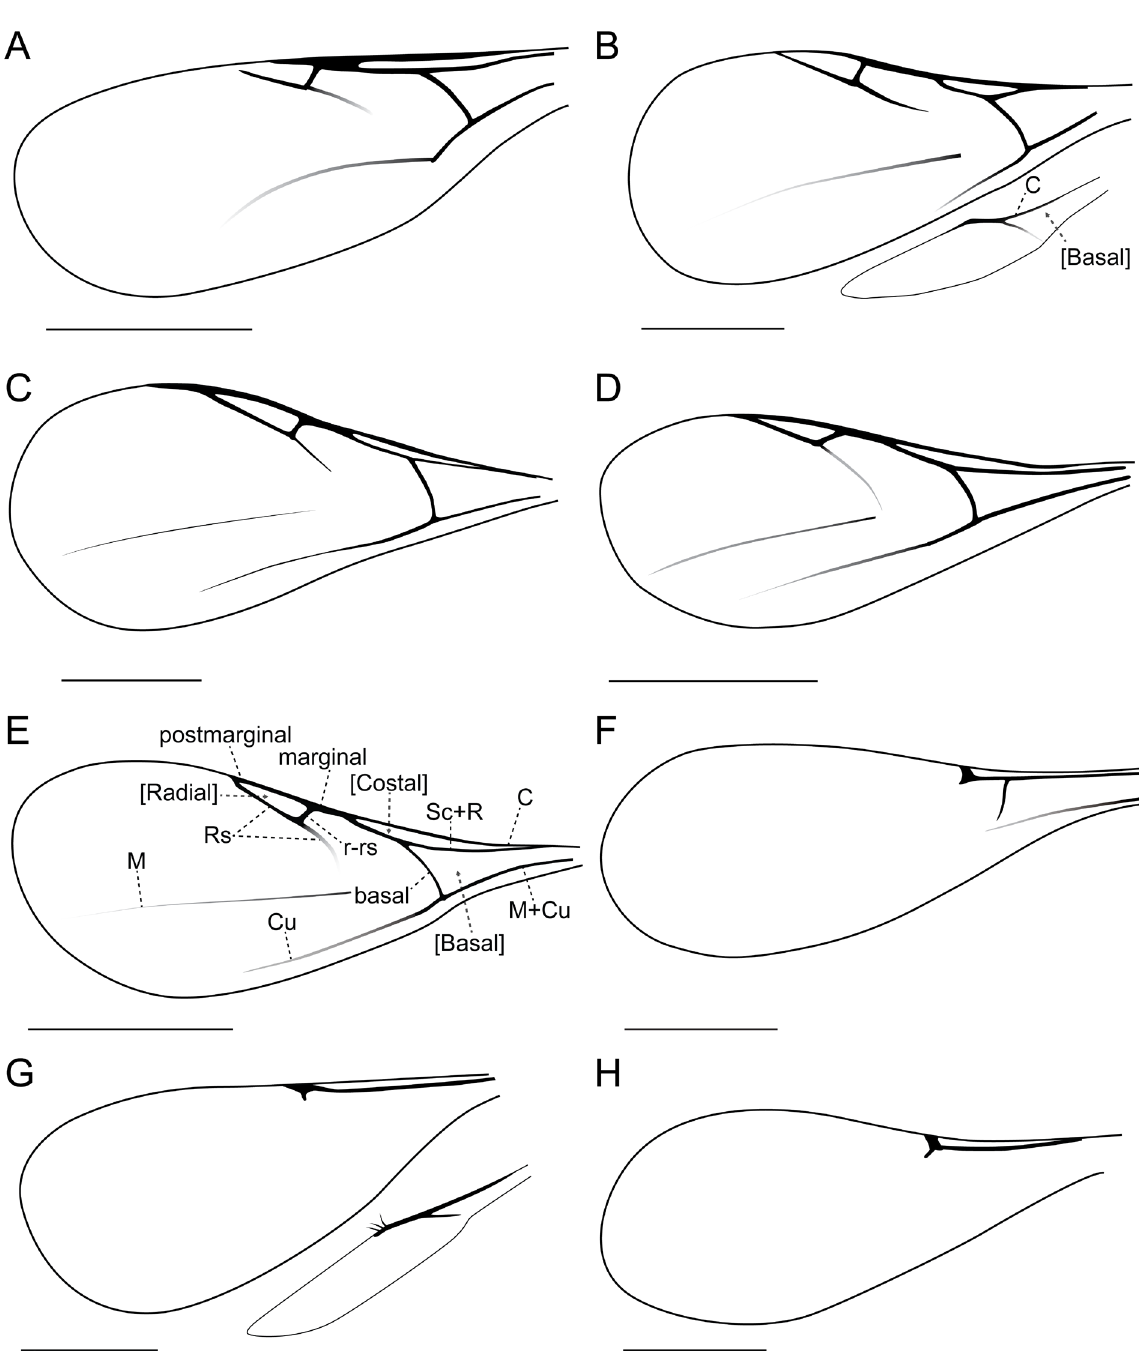
Fig. 1. Wing venation of the species described here. A . Belyta knudhoejgaardi sp. nov. B . Cinetus breviscapus sp. nov. C . Cinetus elongatus sp. nov. D . Pantoclis globosa sp. nov. E . Pantolyta augustinusii sp. nov. F . Basalys villumi sp. nov. G . Doliopria baltica sp. nov. H . Spilomicrus succinalis sp. nov. Scale bars: A–E = 1 mm; F, H = 0.5 mm; G = 0.25